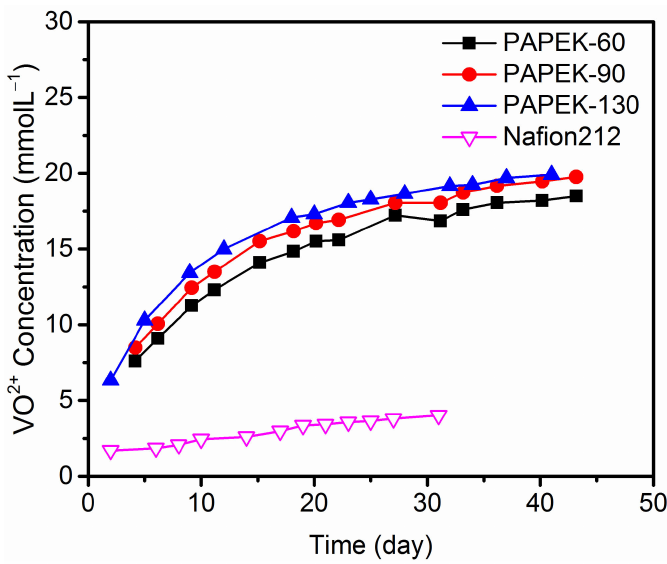
Figure 8. VO 2+ concentration versus soaking time for PAPEK membranes in 0.15 M VO 2 + in 3 M H 2 SO 4